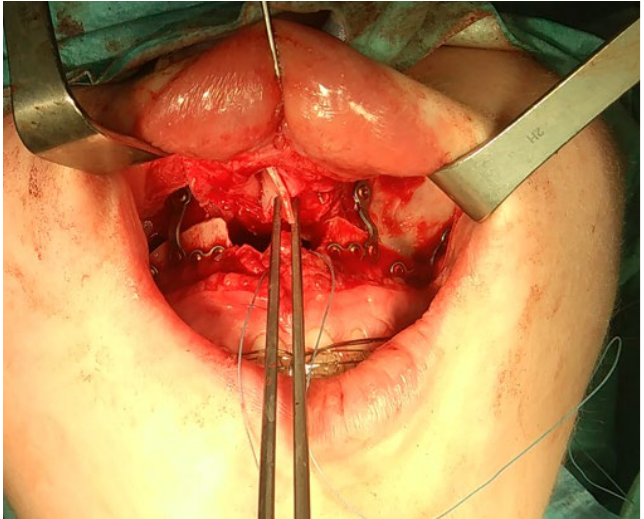
Figure 9. Intraoperative view after Lefort I stable osteosynthesis and nasal septum positioning after septoplasty and conchoplasty reduction procedure.